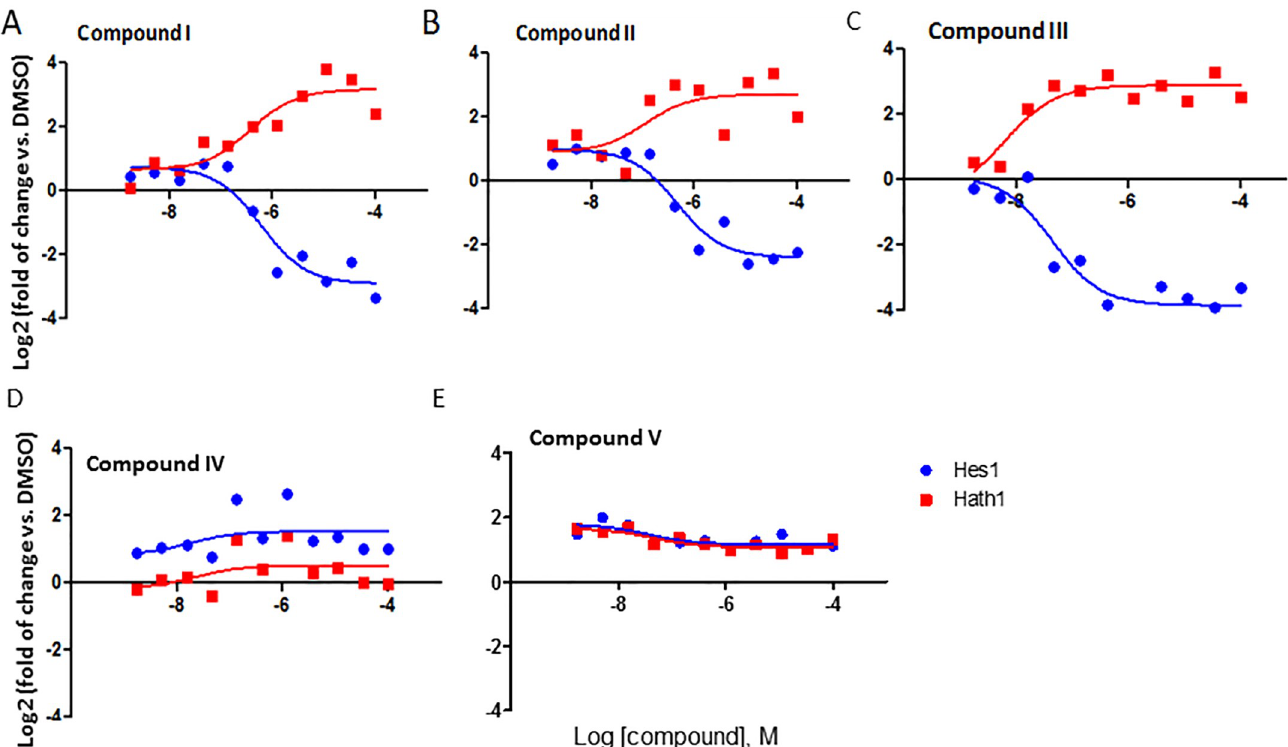
Fig 3. Confirmation of the hits from the Atoh1-Nanoluc reporter screen by RT-PCR for endogenous Atoh1 and Hes1 mRNA. LS-174T cells were treated with compounds for 72hrs and polyA mRNA were extracted on 384-well based Turbocapture plates and used in RT-qPCR analysis for Atoh1 , Hes1 and GAPDH (for housekeeping, not shown) gene expression. Compound I (A), II (B)and III (C) induced dose-dependent Atoh1 gene expression, concomitant with the inhibition on Hes1 gene expression. Compound IV (D) and V (E) were inactive in both Atoh1 induction and Hes1 inhibition. The changes in gene expression ( > 1 for induction) or ( < 1 for inhibition) are calculated as Δ CT and expressed as log2 (fold of change vs. DMSO).